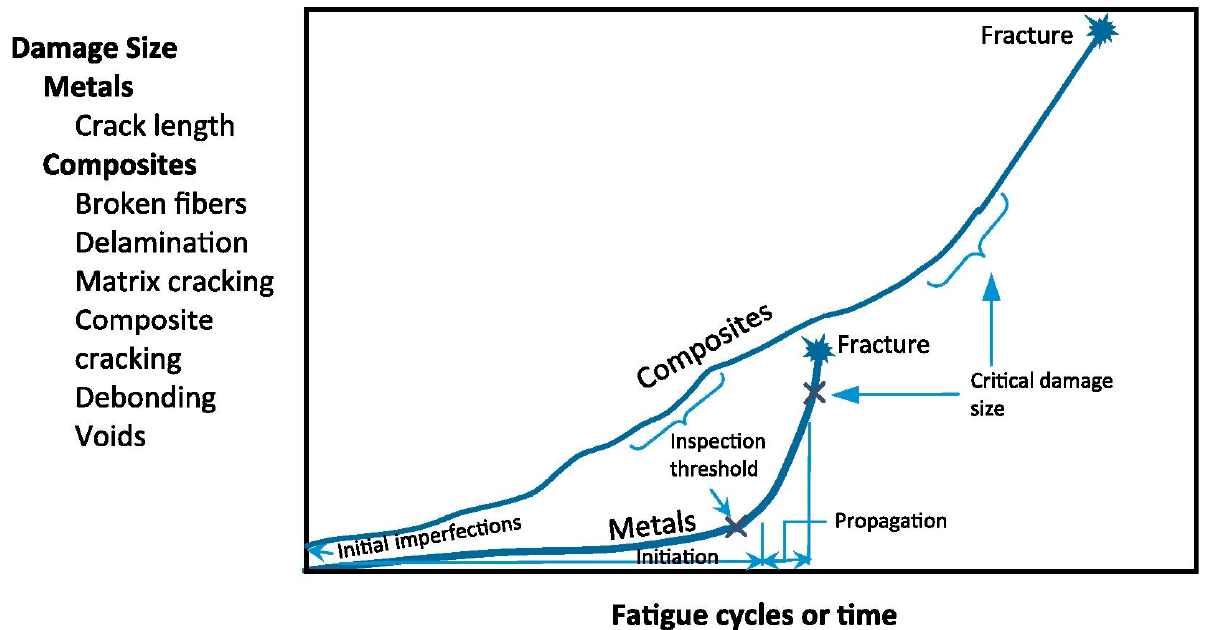
Figure 28. The schematic illustration of the difference between fatigue damage mechanisms between PMCs and metals, adapted with permission from Ref. [64]. Copyright © 2020 Elsevier